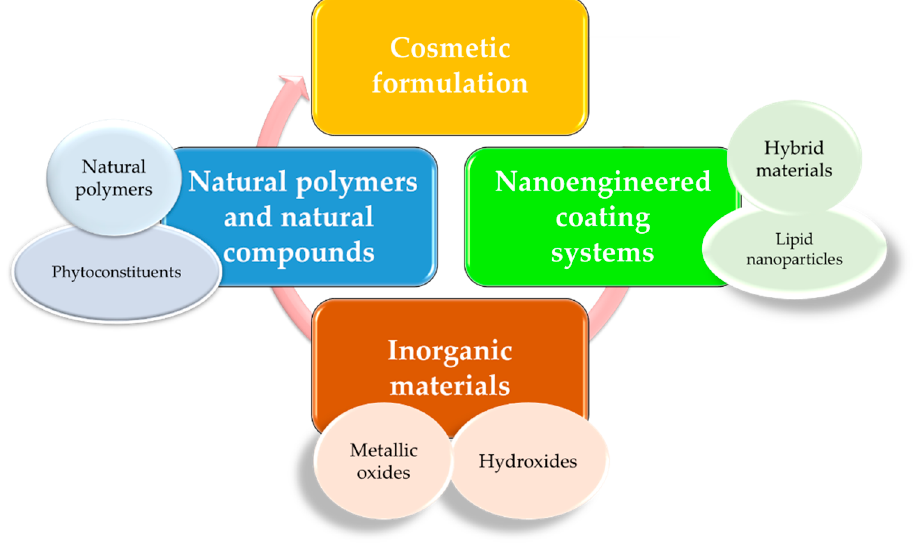
Figure 3. Potential coating materials for cosmetic formulation.